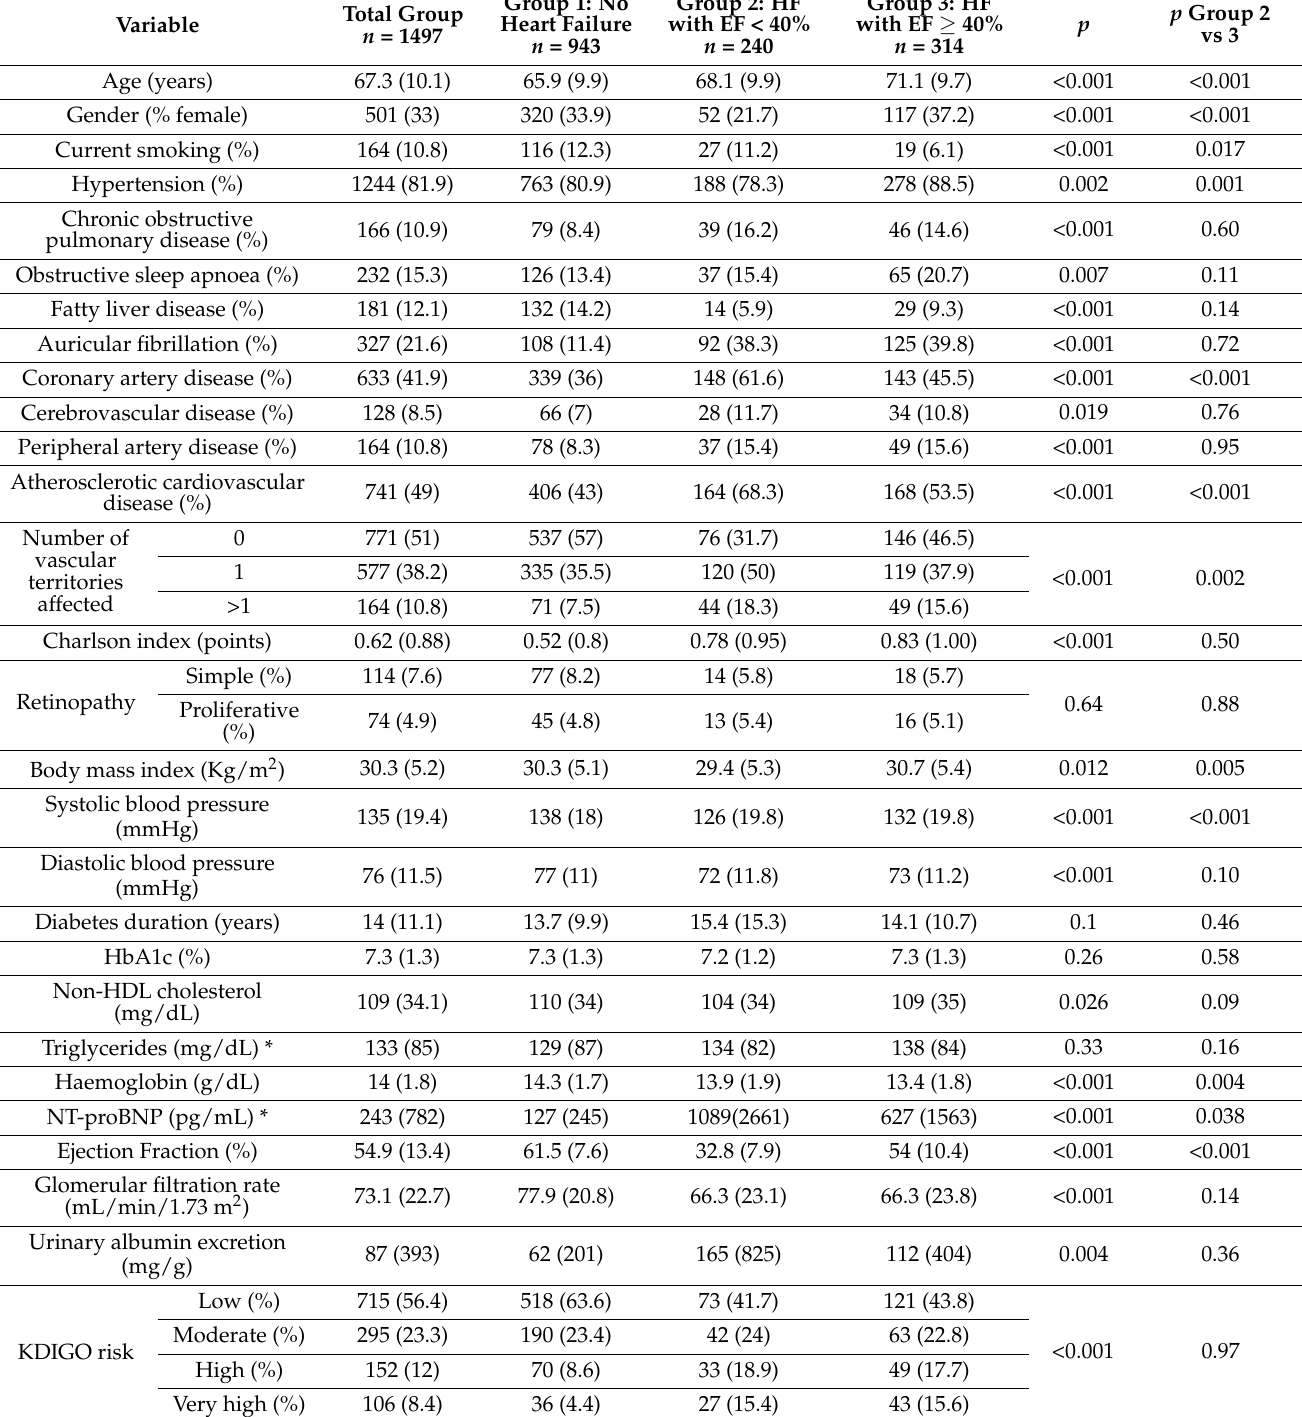
Table 2. Patients’ baseline characteristics based on the type of